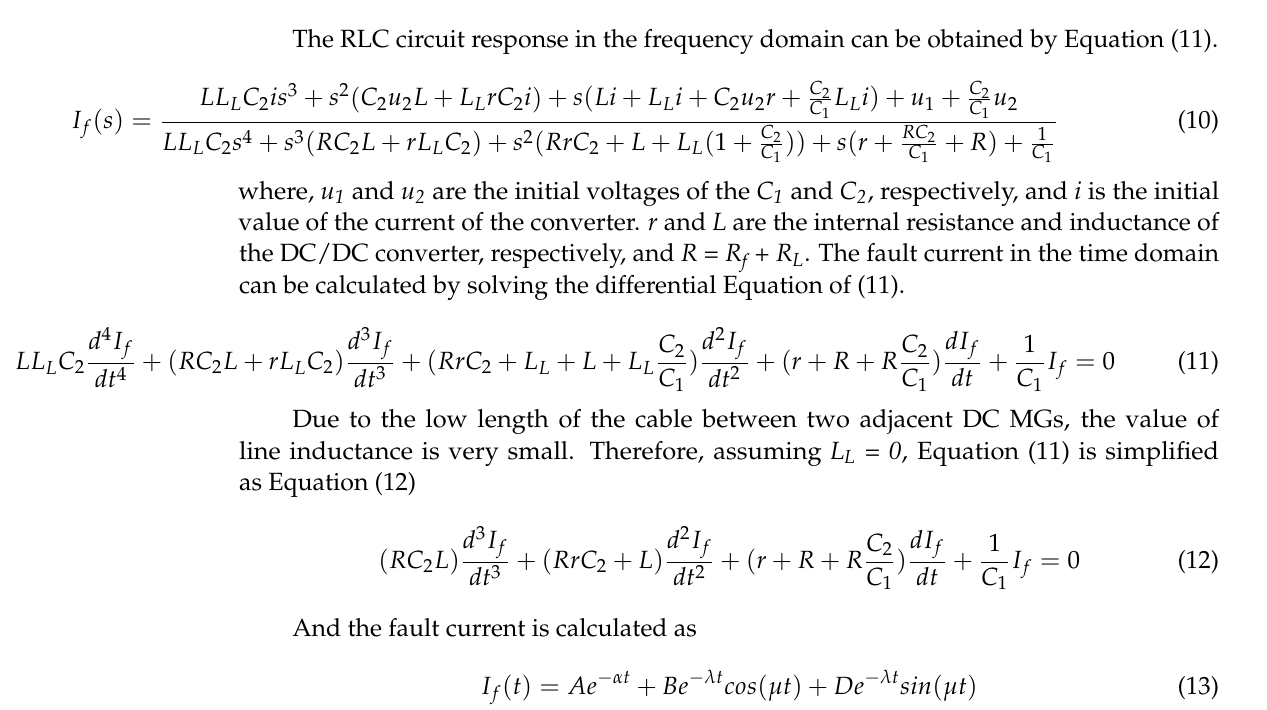
Figure 4. Equivalent circuit of DC/DC converter during capacitor discharge.